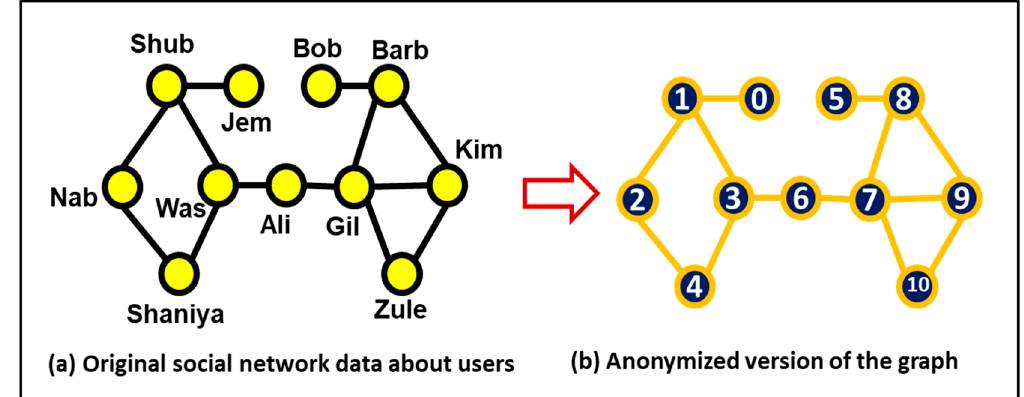
Figure 40. Example of the social network anonymization given in the form of a graph.